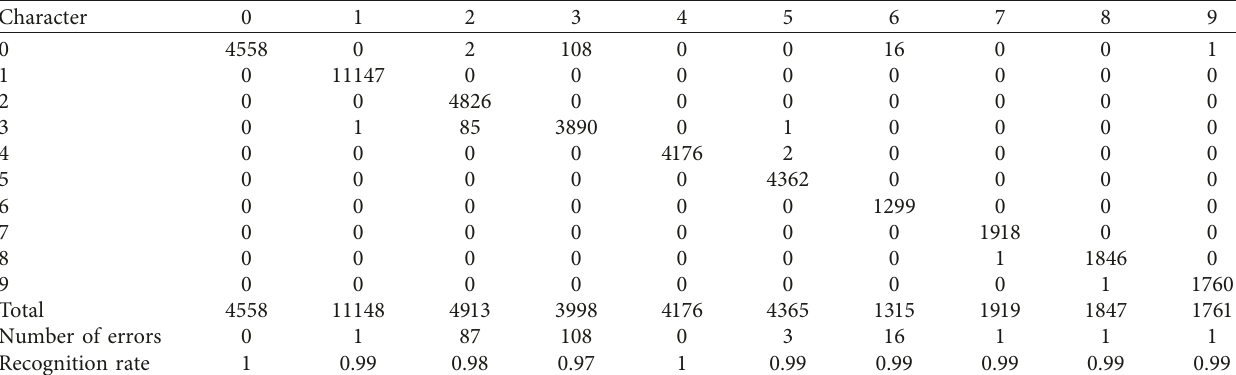
Table 4: Confusion matrix of character recognition